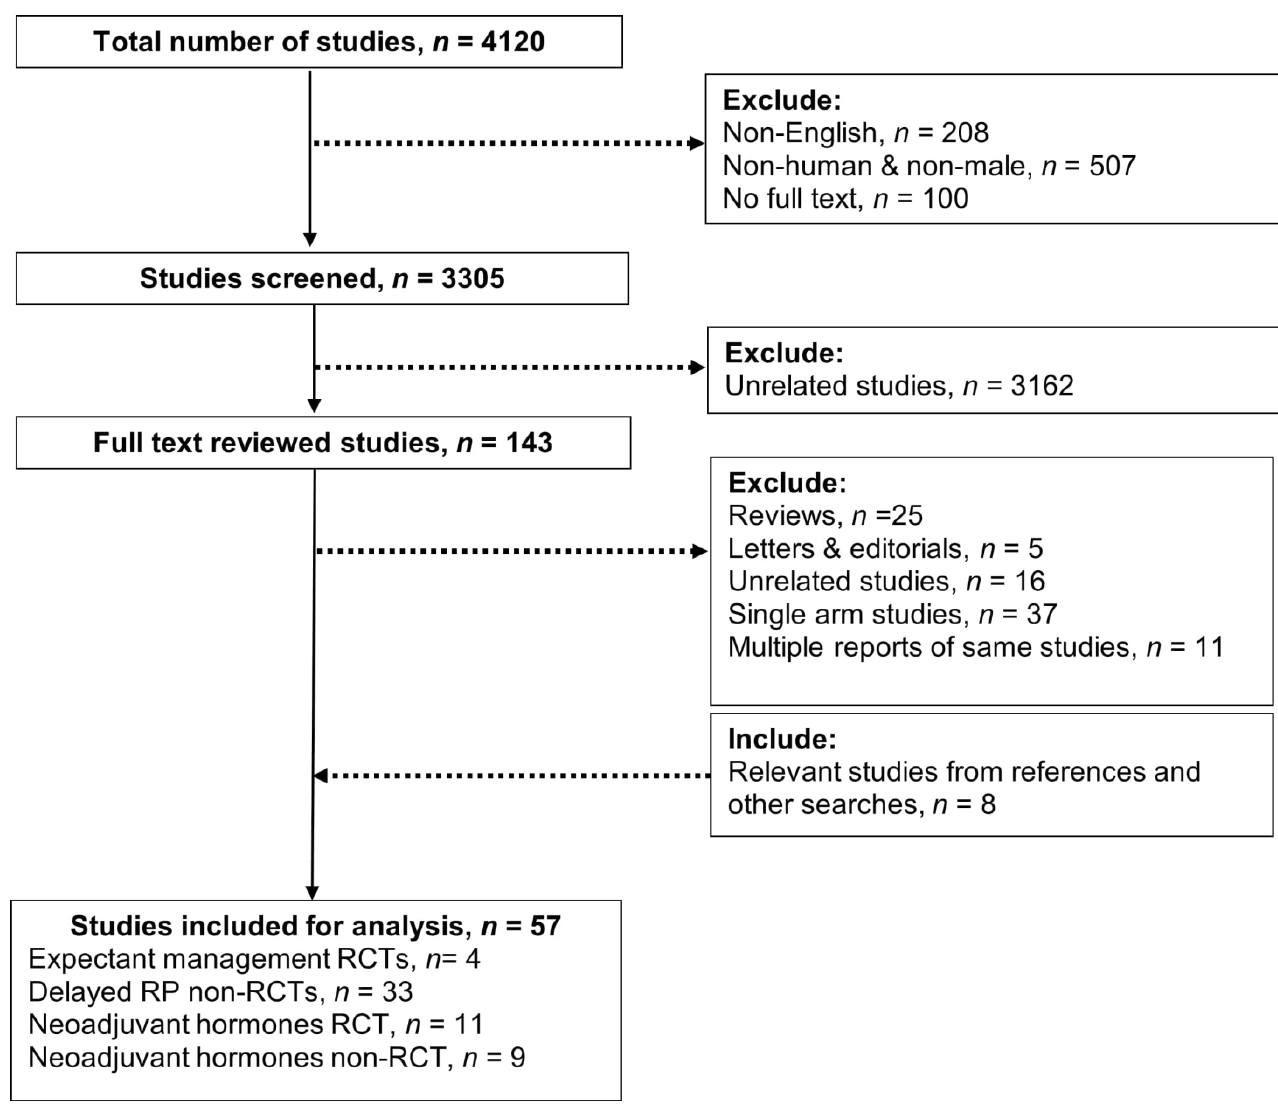
Figure 1. PRISMA Flow Chart.